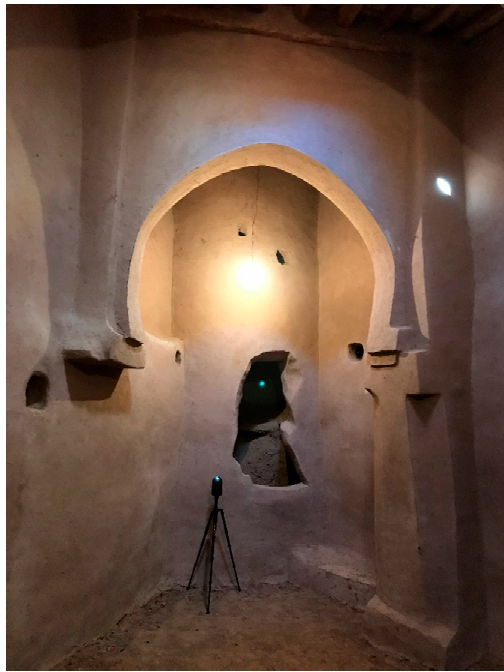
Figure 10. Synagogue in Amezrou (inside BLK360 laser scanner).